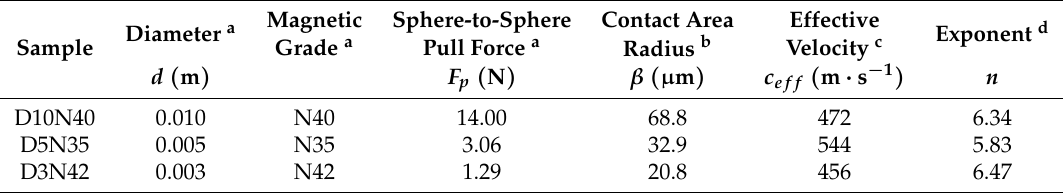
Table 1. Magnetic spheres: manufacturer specifications and deduced physical parameters.